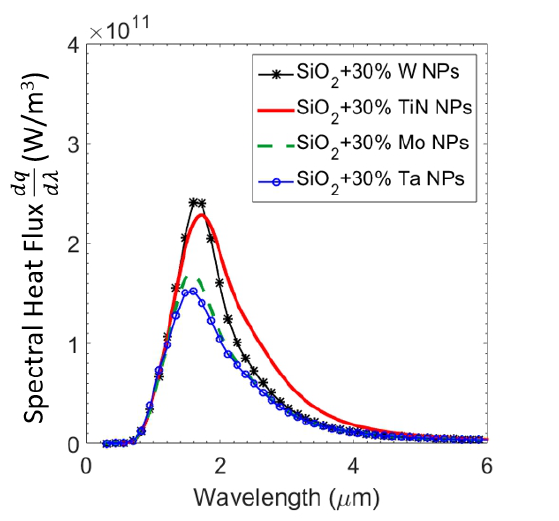
Figure 6. Spectral heat flux across the emitter consisting of nanoparticles of alternative materials and the GaSb PV cell at a separation of L = 100 nm for a nanoparticles volume fraction of